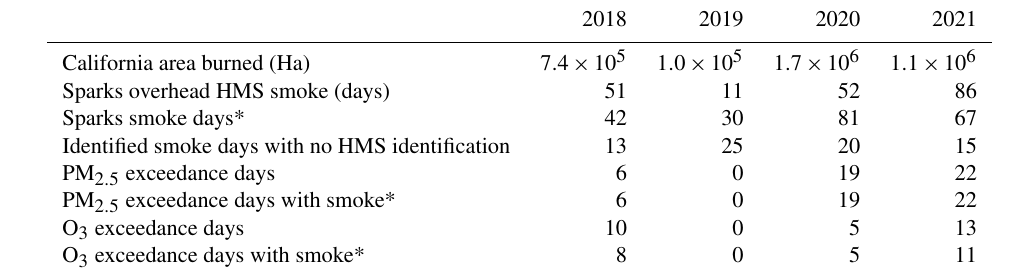
Table 2. California area burned, overhead HMS smoke days, and days over the U.S. National Ambient Air Quality Standard at Sparks, NV, for PM 2 . 5 (daily mean of 35µgm − 3 ) and O 3 (70ppb, 8h average). The smoke criteria (indicated by *) uses a PM 2 . 5 / CO ratio of